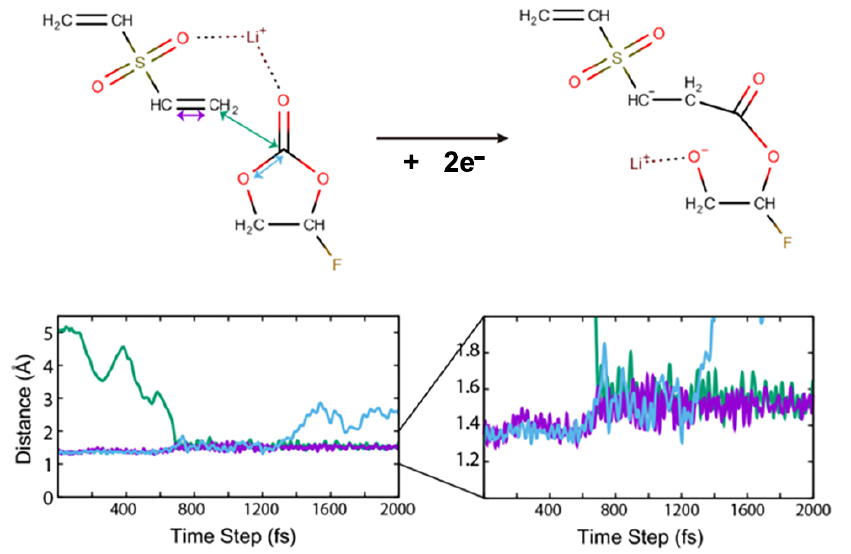
Figure 4. Merging of FEC with DVSF in the electro-reductive condition. One of the double-bonded carbons in vinyl moiety formed a new bond with a carbonyl carbon of FEC. The distances between characteristic atoms show the formation and breaking of bonds. The purple line indicates the distance between two carbon atoms in the vinyl moiety. The increase after the reaction indicates the decrease of bond order. The dark green line indicates C–C bond formation that leads to the merging of two molecules. The ring-opening of FEC is shown with C–O distance that is marked with cyan